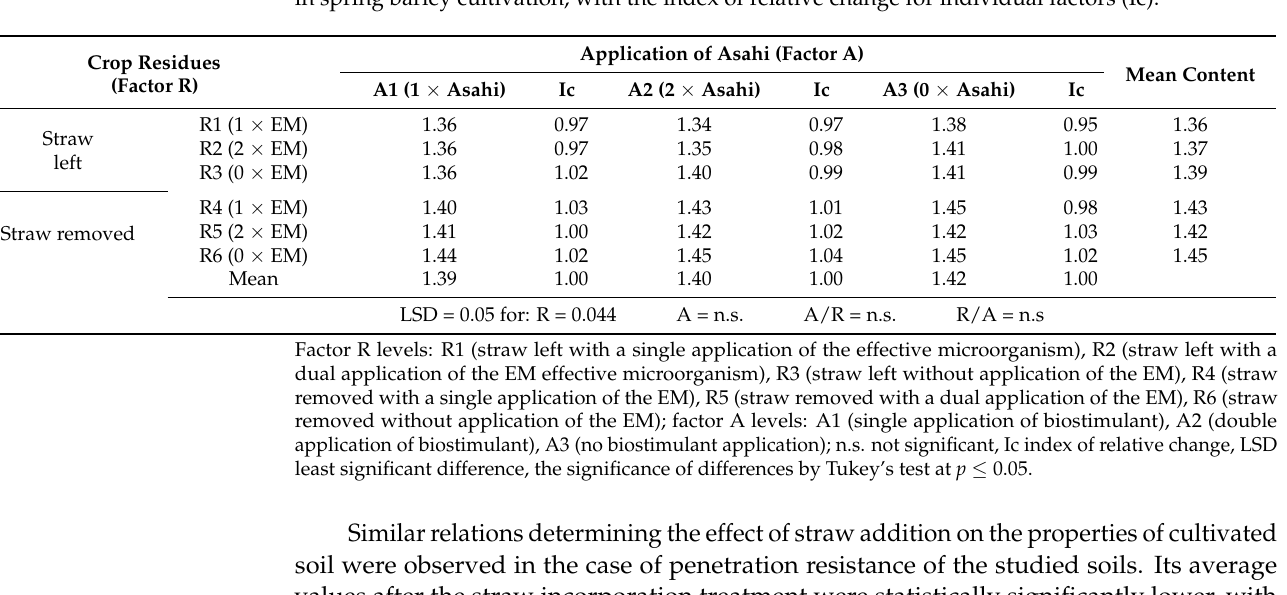
Table 1. Soil bulk density (BD) (g · cm − 3 ) depending on the management of plant residues with the addition of the biopreparation EM (R factor) and the application of the biostimulant Asahi (A factor) in spring barley cultivation, with the index of relative change for individual factors